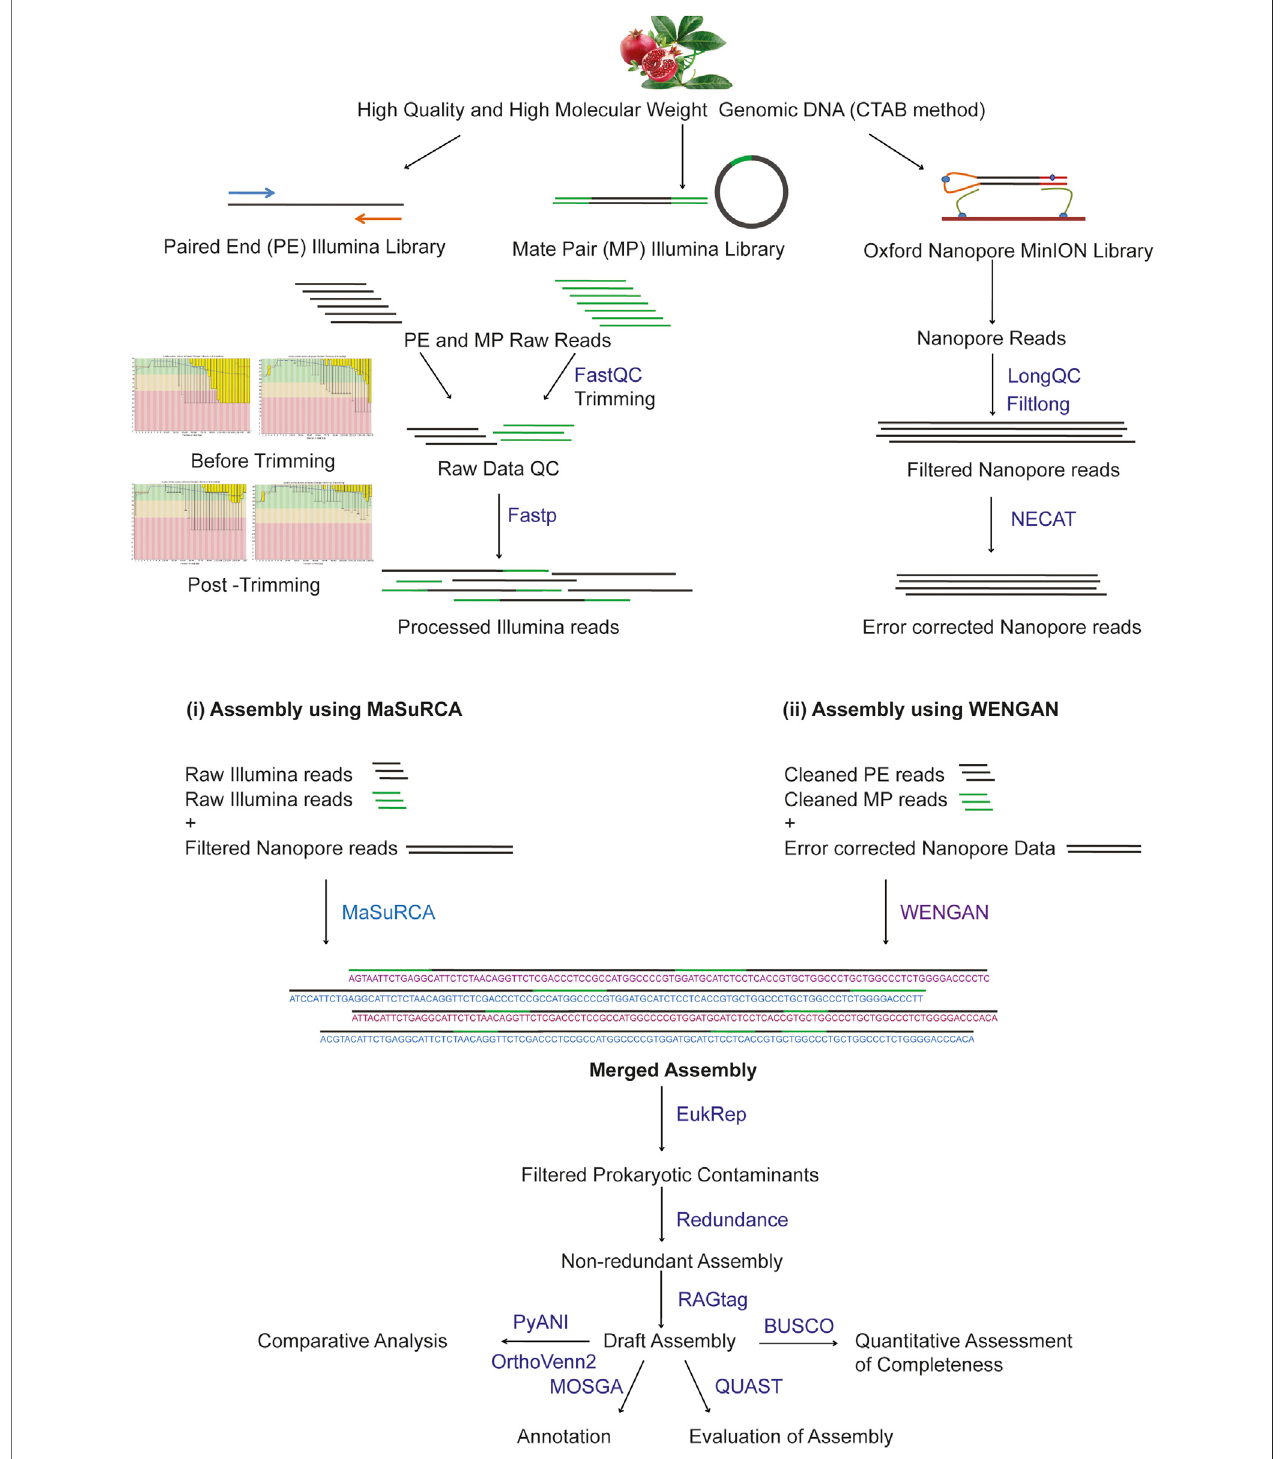
FIGURE 1 | Overview of the study from the isolation of DNA to assembly and analysis of the genome.